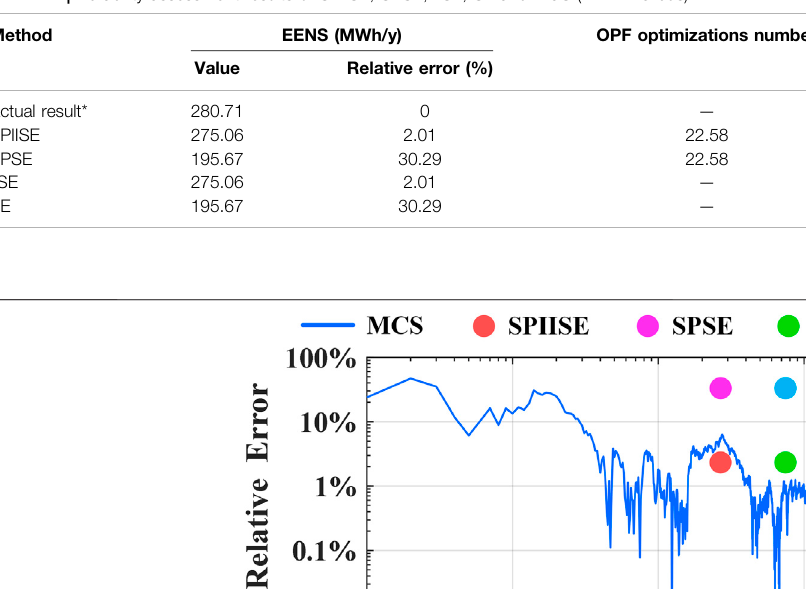
TABLE 4 | Reliability assessment results of SPIISE, SPSE, IISE, SE and MCS (IEEE 118-bus).